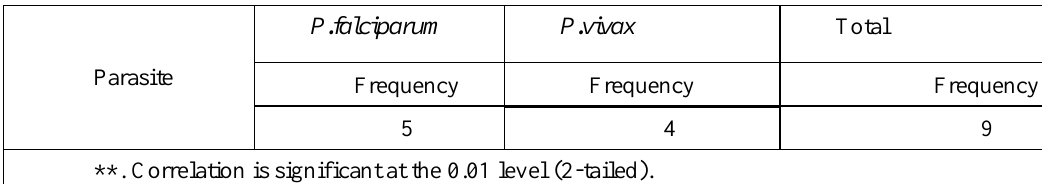
Table 2 . Correlations between positive results.